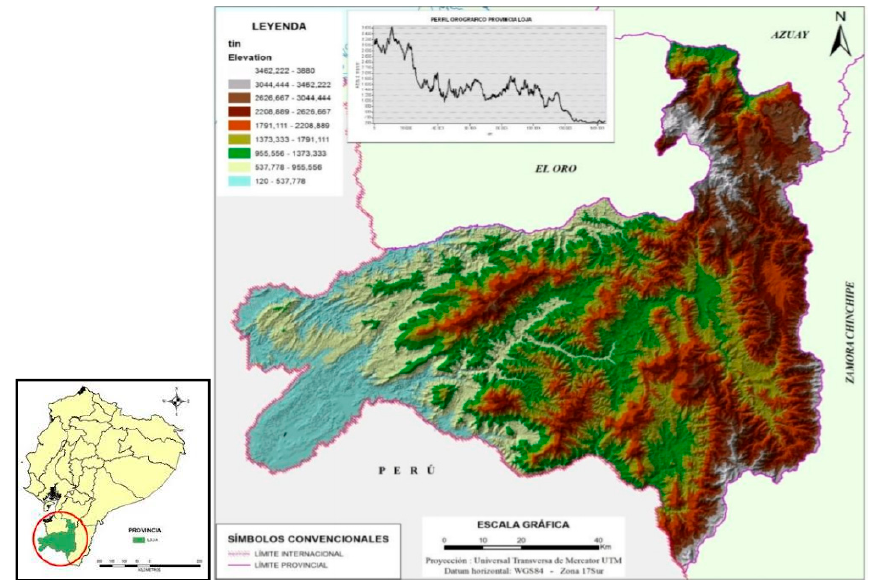
Figure 1. Orographic map of province of Loja-Ecuador.